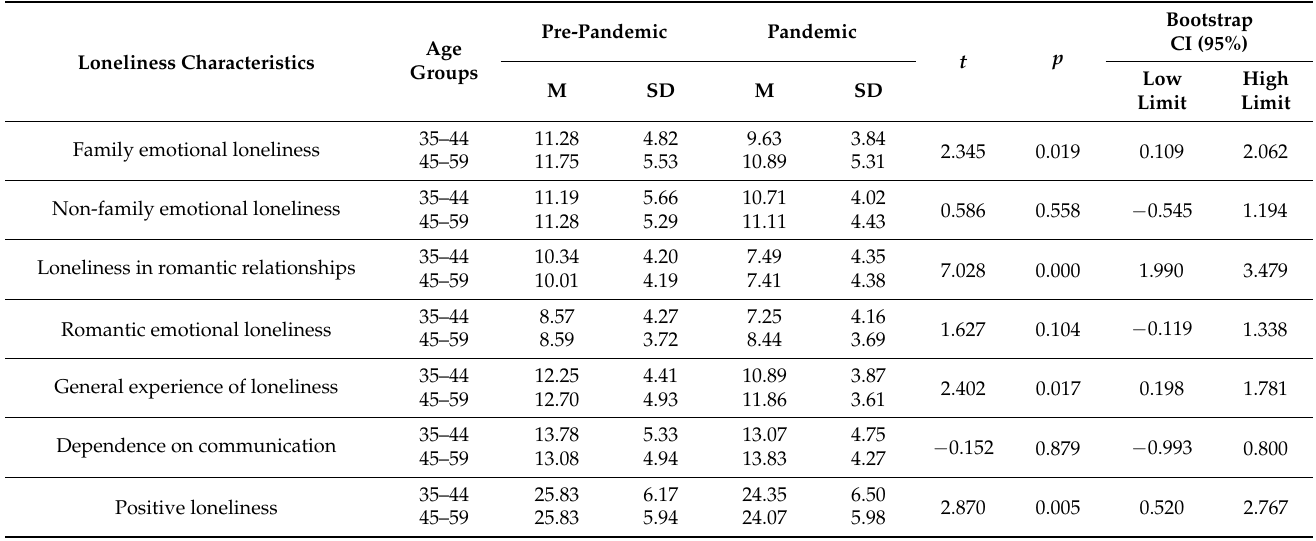
Note. Multivariate ANOVA (MANOVA) did not show any significant differences for factors “Age” and “Pandemic period × Age”. M—mean score, SD—standard deviation, p — p -value, t — t